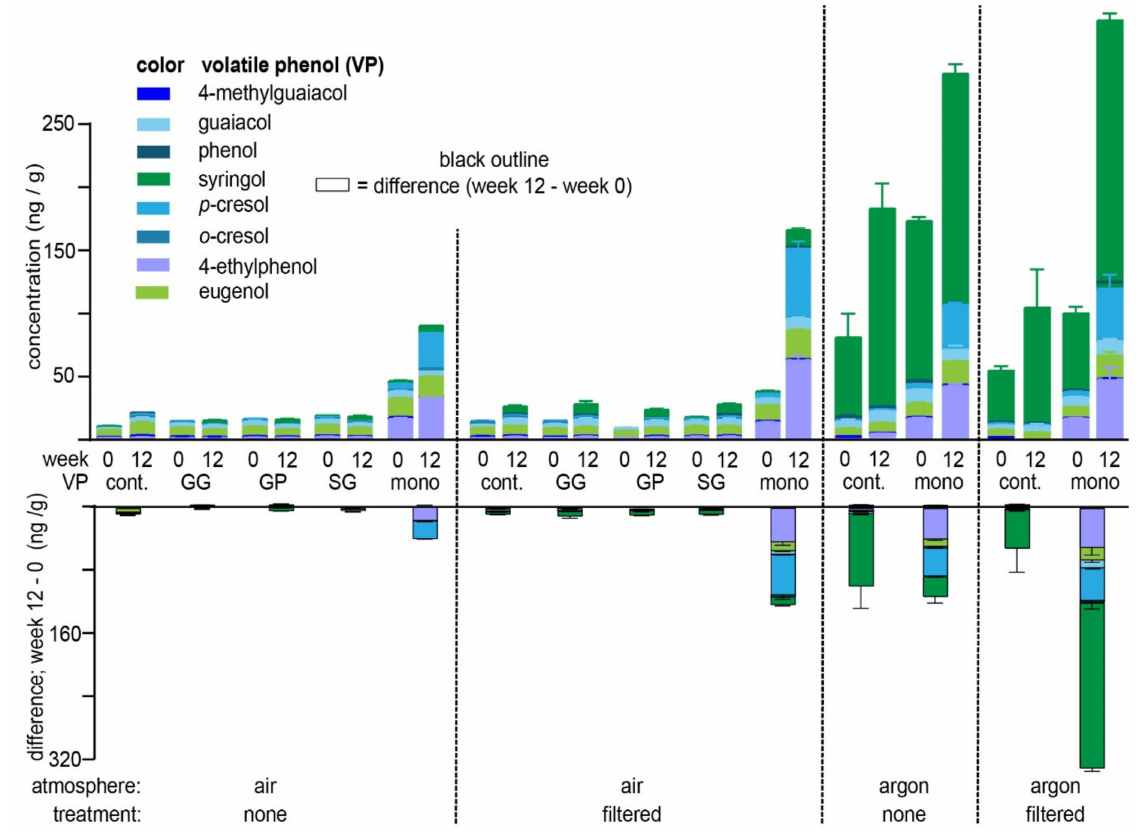
Figure 2. Quantitation of free volatile phenols (VPs) from Cabernet Franc wine that had been fortified with 200 ng/g of VP-glucosides and stored under differing conditions for 12 weeks (top panel). Note that GG, GP, SG, and mono refer to guaiacol-gentiobioside, guaiacol-primeveroside, syringol-gentiobioside and VP-monoglucosides, respectively; cont. = control, i.e., unfortified samples. Error bars depict the standard error of the mean. Bars with black outlines (the lower panel) were calculated by determining the difference between free VP concentrations quantitated at week 12 and week 0; error bars for the difference in VP concentrations denote the sum of the errors in quadrature. Note the top and bottom panels have different y -axis